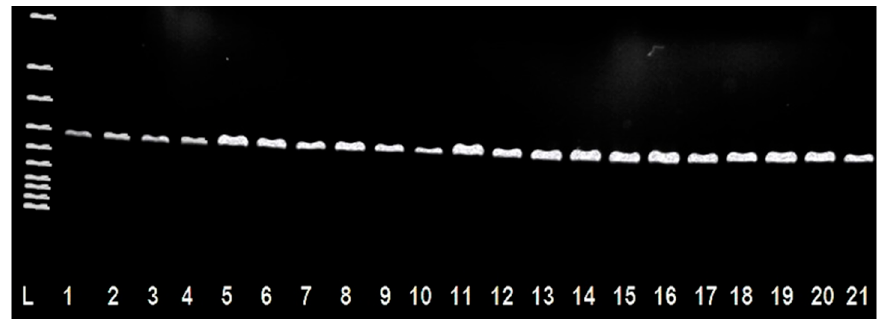
Figure 1. Identification of isolates of Staphylococcus spp. from sheep’s milk and cheese using the PCR method (420 bp). L: 100 bp ladder; Line 1: reference strain CCM 4223 S. aureus ; Lines 2–21: isolates Staphylococcus spp.